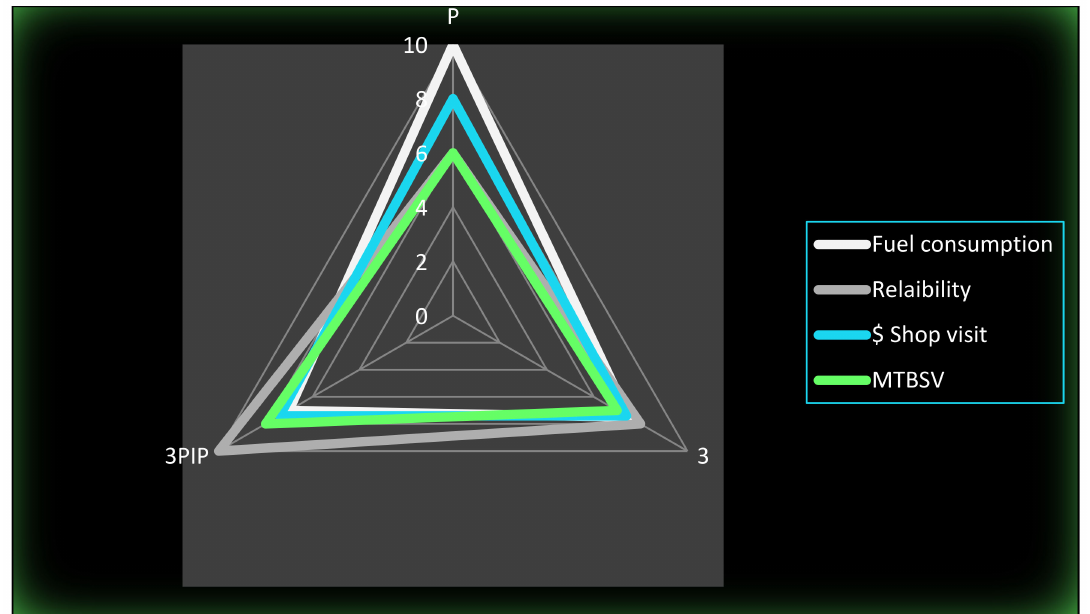
Figure 14. Synthesis of all the